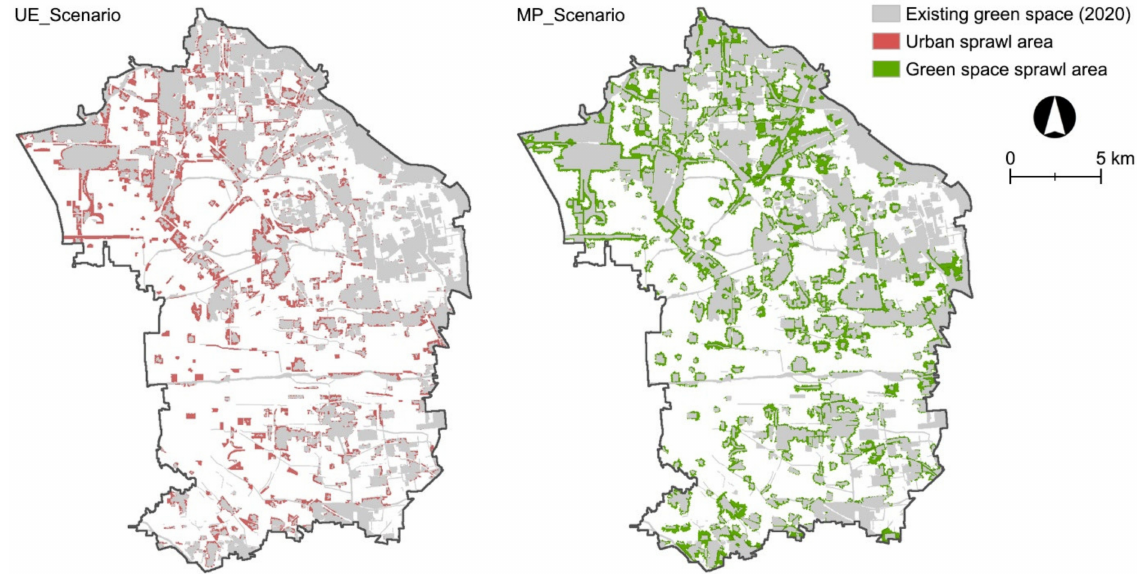
Figure 2. Simulation of urban sprawl (in red) under UE_Scenario and green space sprawl (in green) under MP_Scenario.